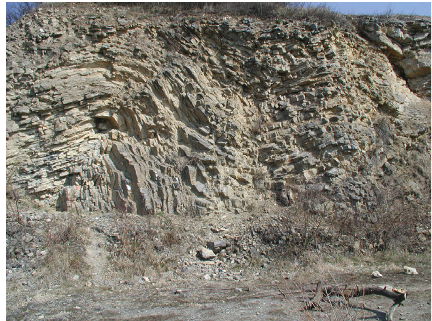
Figure 2: The network of rock joints uncovered as a result of excavation work at lime quarry H´ady near to the city of Brno in the Czech